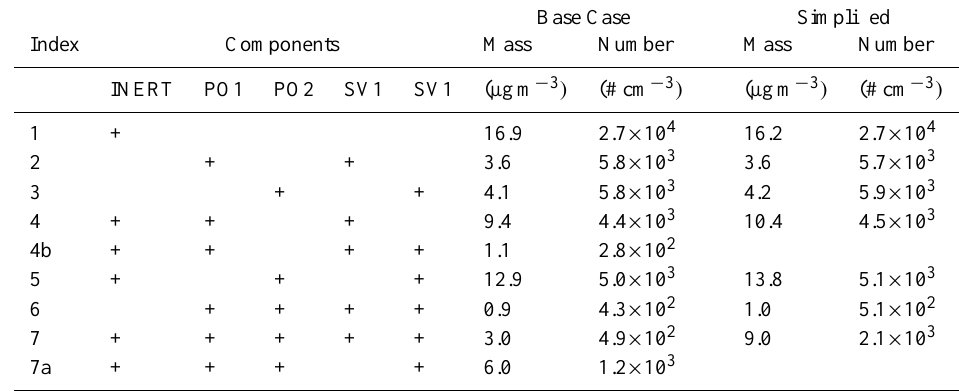
Table 4. Major populations ∗ formed at t =188 h in base case and simplified scenarios with an external mixture.